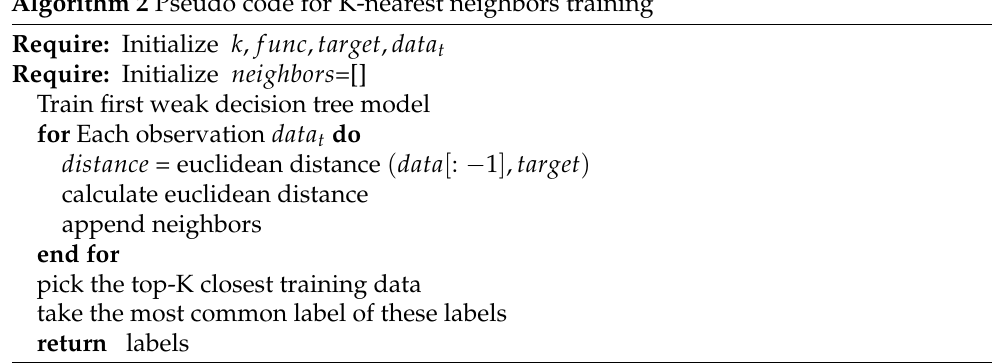
Algorithm 2 Pseudo code for K-nearest neighbors training